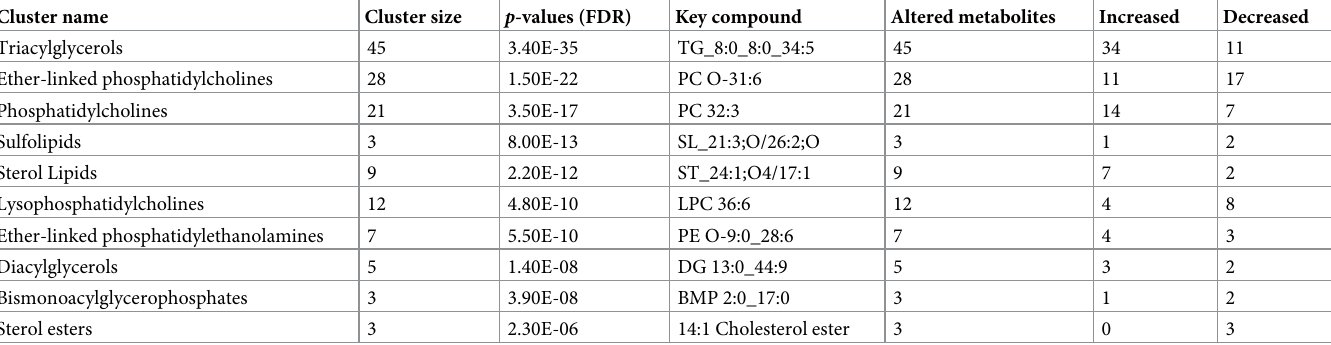
Table 2. Results of the ChemRICH enrichment analysis for the altered metabolites following the comparison L vs CTRL diets. Cluster name